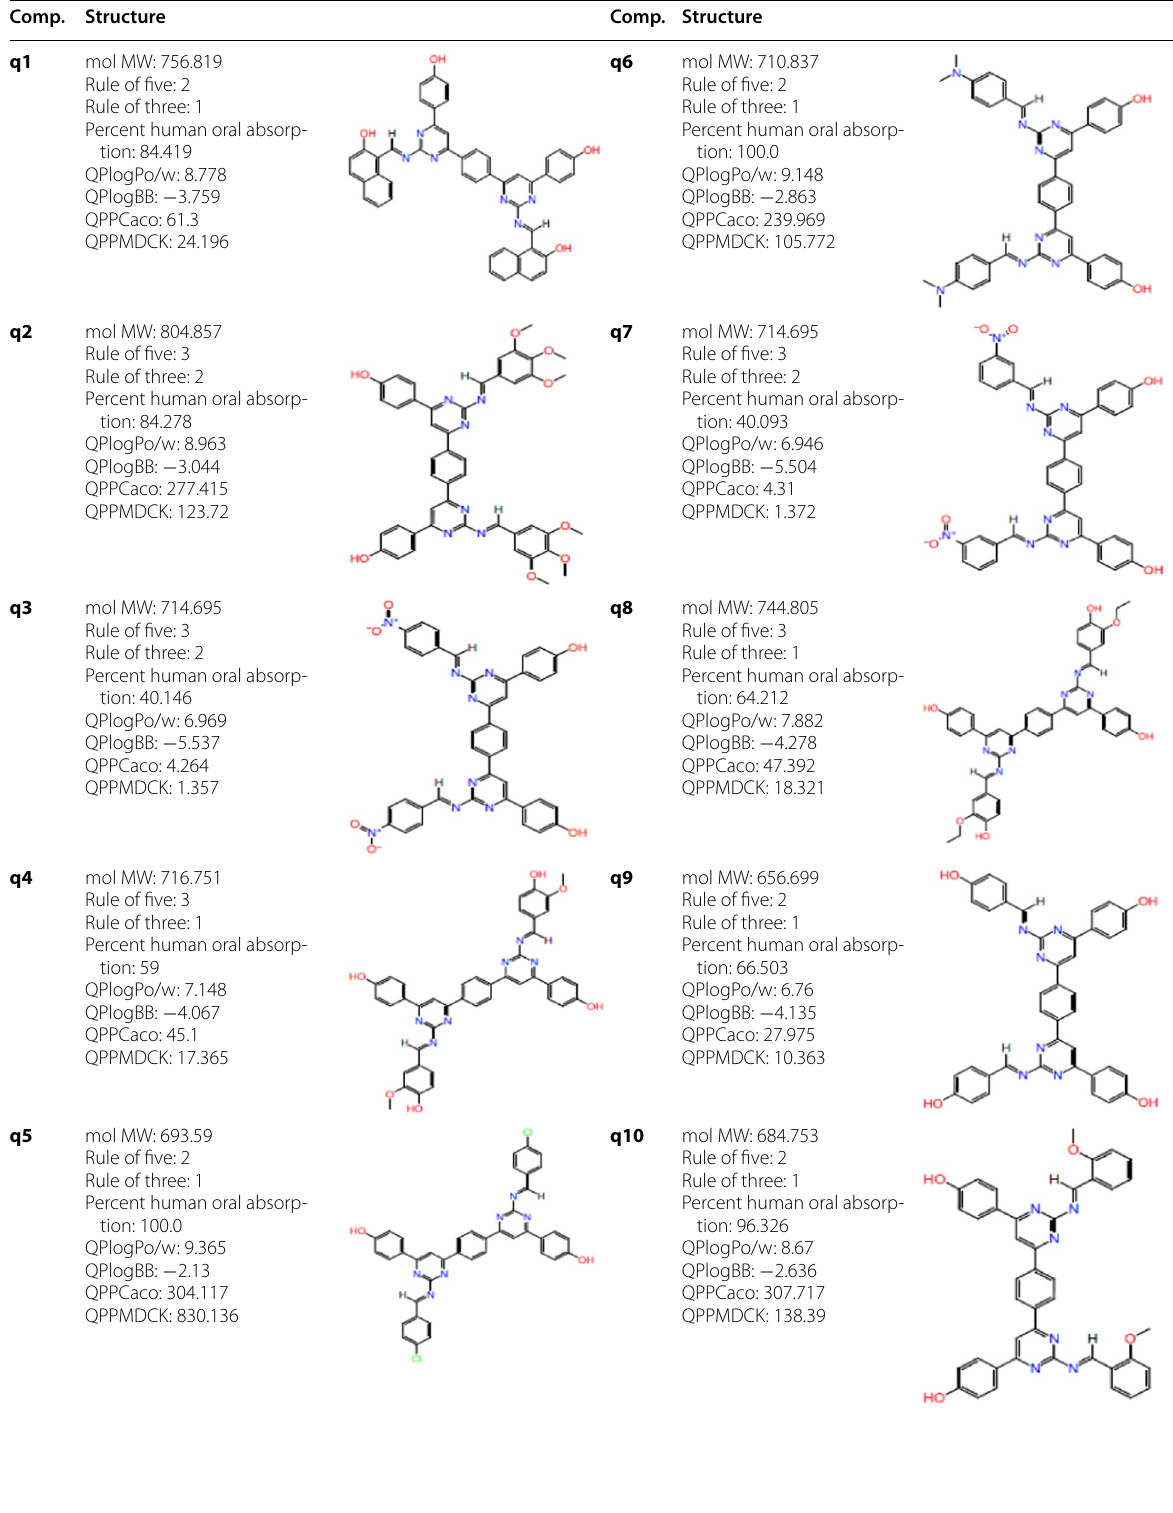
Table 2 QikProp ADMET Prediction of twenty bis-pyrimidine derivatives Comp.